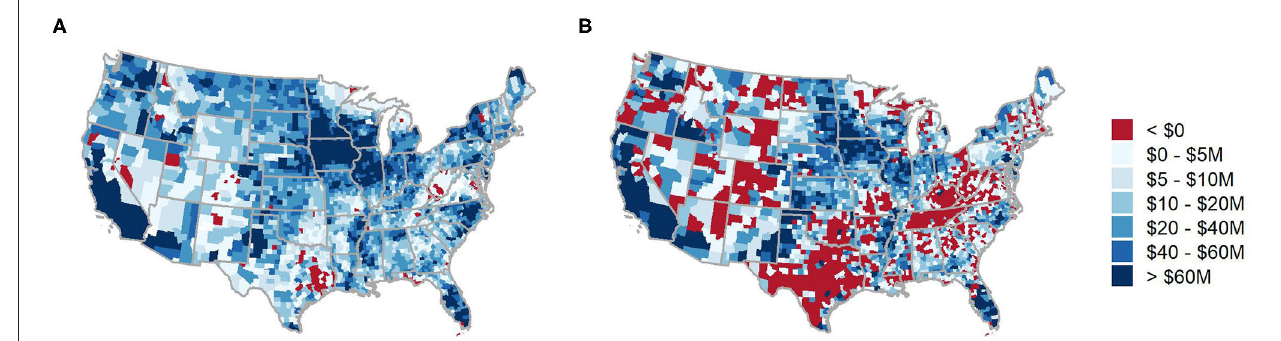
FIGURE 7 | Realized net income of farmers in (A) 1969 (adjusted to 2019 dollars) and (B) 2019. Net income is defined as total cash receipts from all farms less production expenses 15 and is analogous to USDA NASS measures of net cash farm income. We visualize BEA realized net income data because it dates back to 1969 while USDA NASS county-level data only dates back to 1997. Counties in which net income is negative (red) had average production expenses that surpassed total cash receipts. For instance, Parker, TX realized $17M in 1969, but -$67M in 2019. Data: US